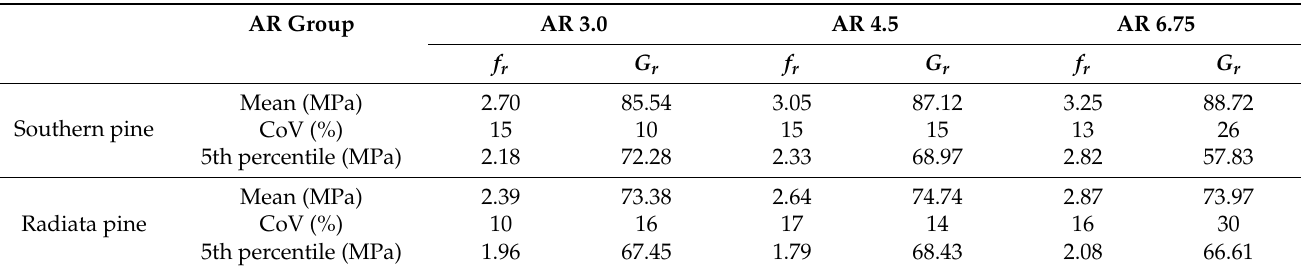
Table 6. Rolling shear properties with varying AR.